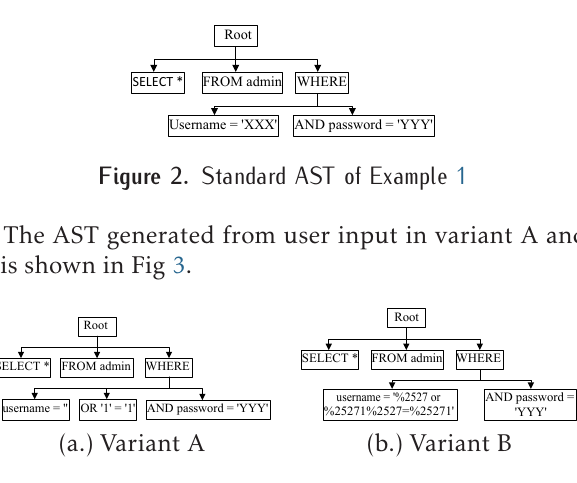
Figure 3. The Generated ASTs from Both